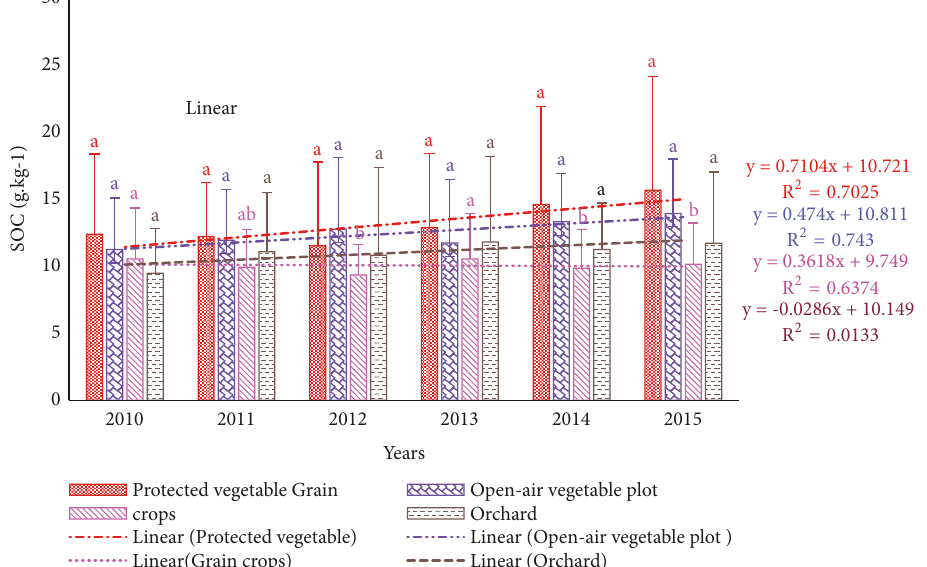
Figure 5: The SOC content in different planting system and different year. Values with same letter in the same planting system indicate that the SOC is not significant different with time (p > 0.05). In the equation, x and y, respectively, indicated the year number (1, 2, .. . , 6) and soil organic carbon